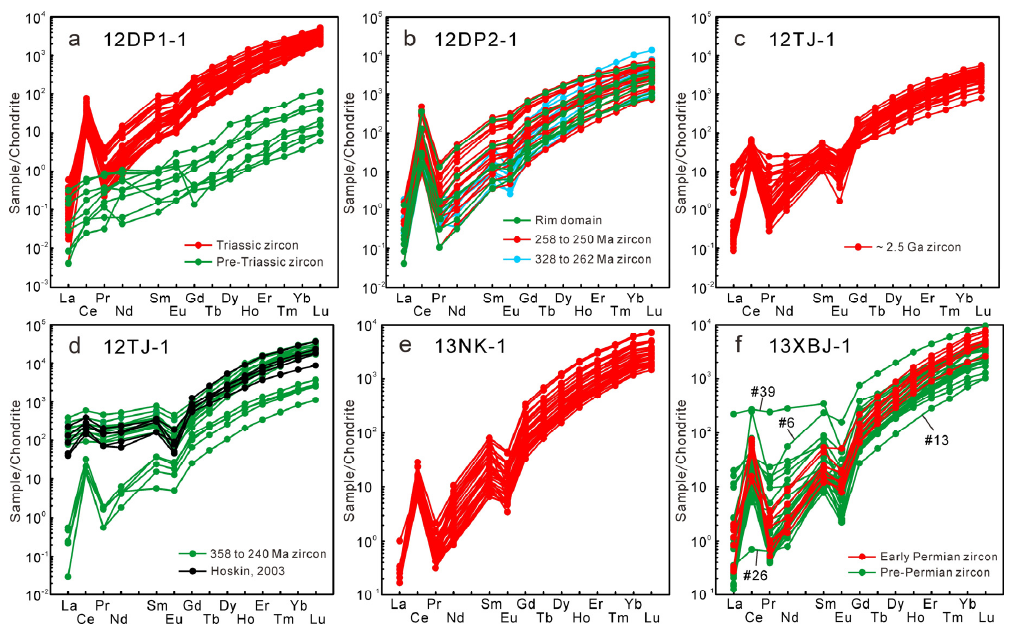
Figure 8. Chondrite-normalized REE patterns of zircons from the ( a , b ) gneisses, ( c , d ) actinolite schist, Figure 8. Chondrite ‐ normalized REE patterns of zircons from the ( a,b ) gneisses, ( c,d ) actinolite schist, ( e ) leptynite and ( f ) hornblende ‐ biotite schist in this study. ( e ) leptynite and ( f ) hornblende-biotite schist in this study. Zircons from sample TJ ‐ 1 display different REE patterns (Figure 8c,d). The REE composition of Based on the chondrite normalized REE patterns (Figure 8b), the pre-Triassic zircons from sample ~2.5 Ga zircons is similar to magmatic zircons showing the positive Ce (Ce/Ce* = 2.17–138.10) and 12DP2-1 can be divided into two groups (I and II). Group-I zircons have 206 Pb / 238 U ages of 258 to 250 Ma negative Eu anomalies (Eu/Eu* = 0.05–0.36) and the depletion in LREEs ((Lu/Gd) N = 11.27–61.99), and exhibit HREE enrichment with (Lu / Gd) N of 8.94 to 93.98, together with pronounced positive Ce suggesting that the trace element system of protolith zircons was not significantly modified during anomalies (Ce / Ce* = 34.6 to 302.3) but weak or negligible Eu anomalies (Eu / Eu* = 0.39 to 0.82) (Table S2). post ‐ magmatic recrystallization and metamorphism. The 358–240 Ma zircons can be divided into Group-II zircons have older 206 Pb / 238 U ages of 328 to 262 Ma and show steeper MREE-HREE patterns two types according to their CL images and REE patterns: (1) five of them (e.g., # 47) exhibit weak oscillatory zoning and magmatic REE patterns with significant HREE enrichment, positive Ce anomalies, and negative Eu anomalies (Figure 8d), and (2) ten of them are homogeneous with no CL MSWD = 0.23) of group-I zircons (mantle-a ffi nity zircons) is interpreted to most accurately response and are enriched in the REEs, especially the light rare earth elements (LREEs), with negative Eu anomalies but weak/negligible Ce anomalies (Figure 6d), which are similar to those of the hydrothermal zircons of Boggy Plain zoned pluton [109], indicating that these zircons are